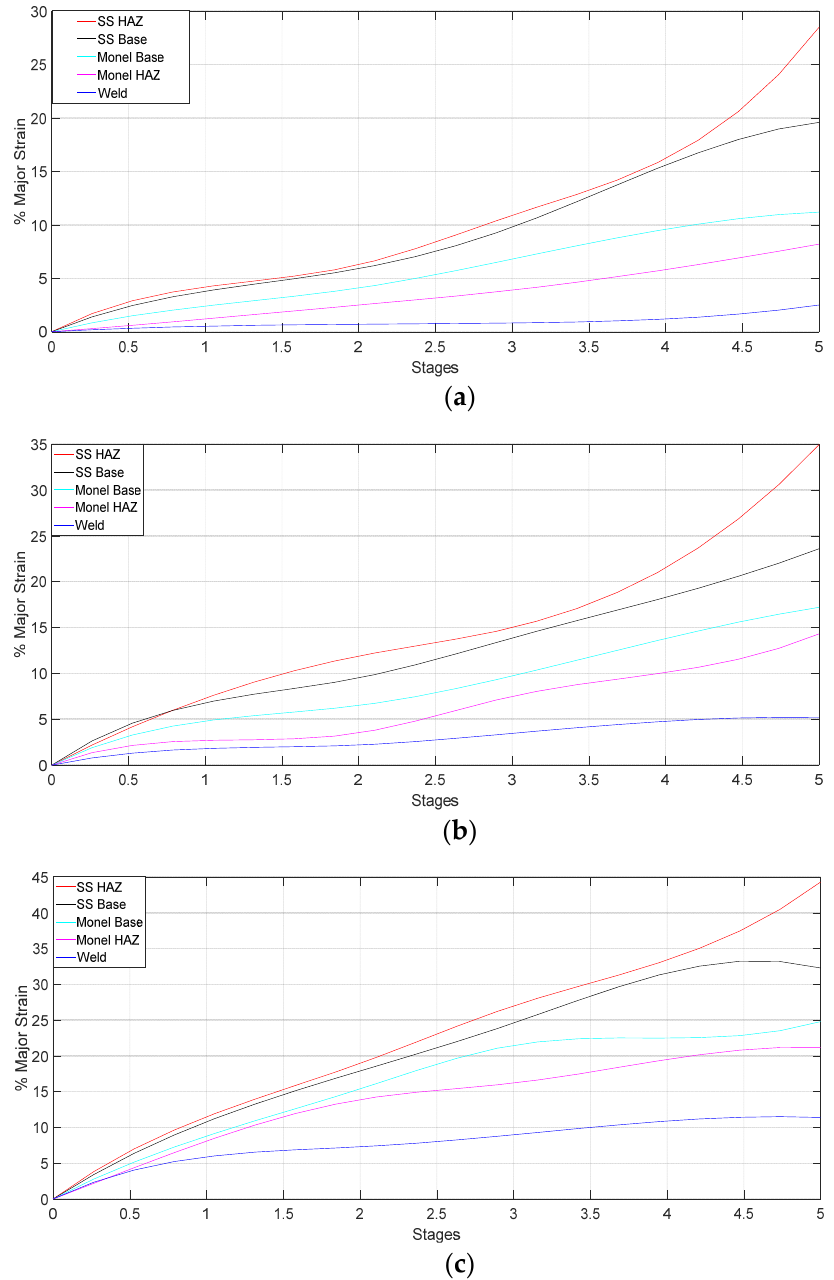
Figure 12. Local stress strain curves of different zones of the weld joint: ( a ) UT specimen; ( b ) HT specimen; ( c ) CT specimen.